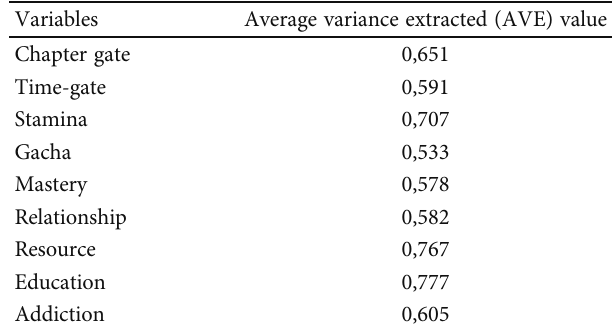
Table 1: Variable and indicator measurement. Table 2: Average variance extracted